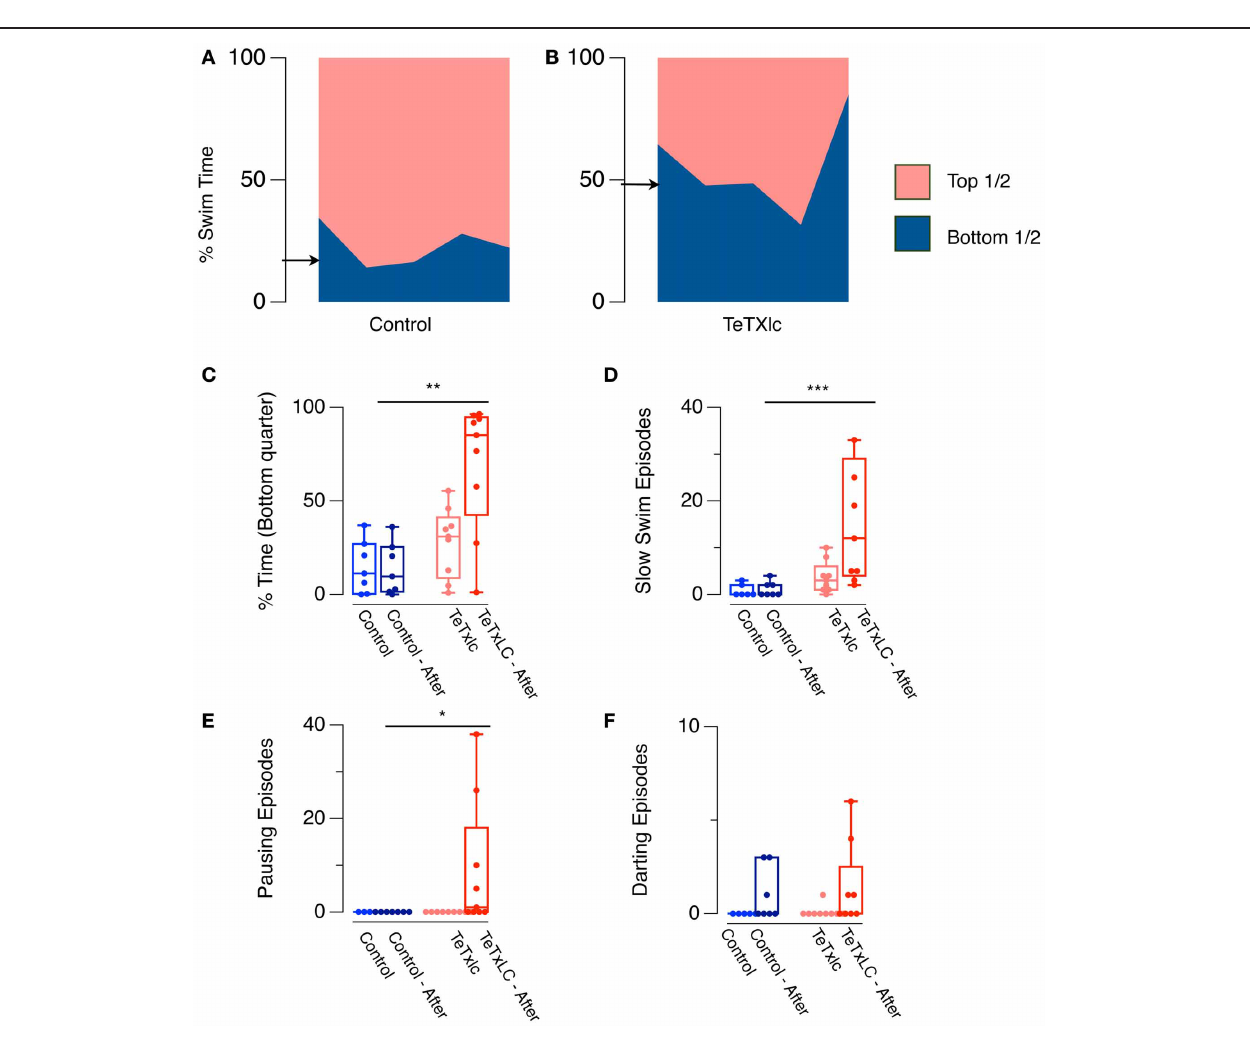
FIGURE 1 | (A,B) Novel tank assay. Area in each color shows percentage time spent in either half of a novel tank in one minute by five Control fish and five TeTXlc expressing fish. Arrows indicate median swim time in the bottom half for controls (20.4 ± 3.7%) and TeTXlc fish (48.6 ± 9%). (C–F) Response to dilute alarm substance and an overhead shadow. (C) Time spent in the bottom quarter of a tank, and median number of (D) slow swimming, (E) pauses, and (F) darts. Non-parametric, Mann–Whitney U -test was used to compare behavior of control and TeTXlc fish following exposure to the stimuli. (Mann–Whitney U -test, ∗ p < 0 . 05, ∗∗ p < 0 . 01, ∗∗∗ p < 0 . 001). Zebrafish expressing TeTXlc-CFP in the habenula were generated by crossing GAL4 s1019t with UAS:TeTXlc-CFP, and selected on the basis of CFP fluorescence in the brain. For the novel tank assay, fish were transferred